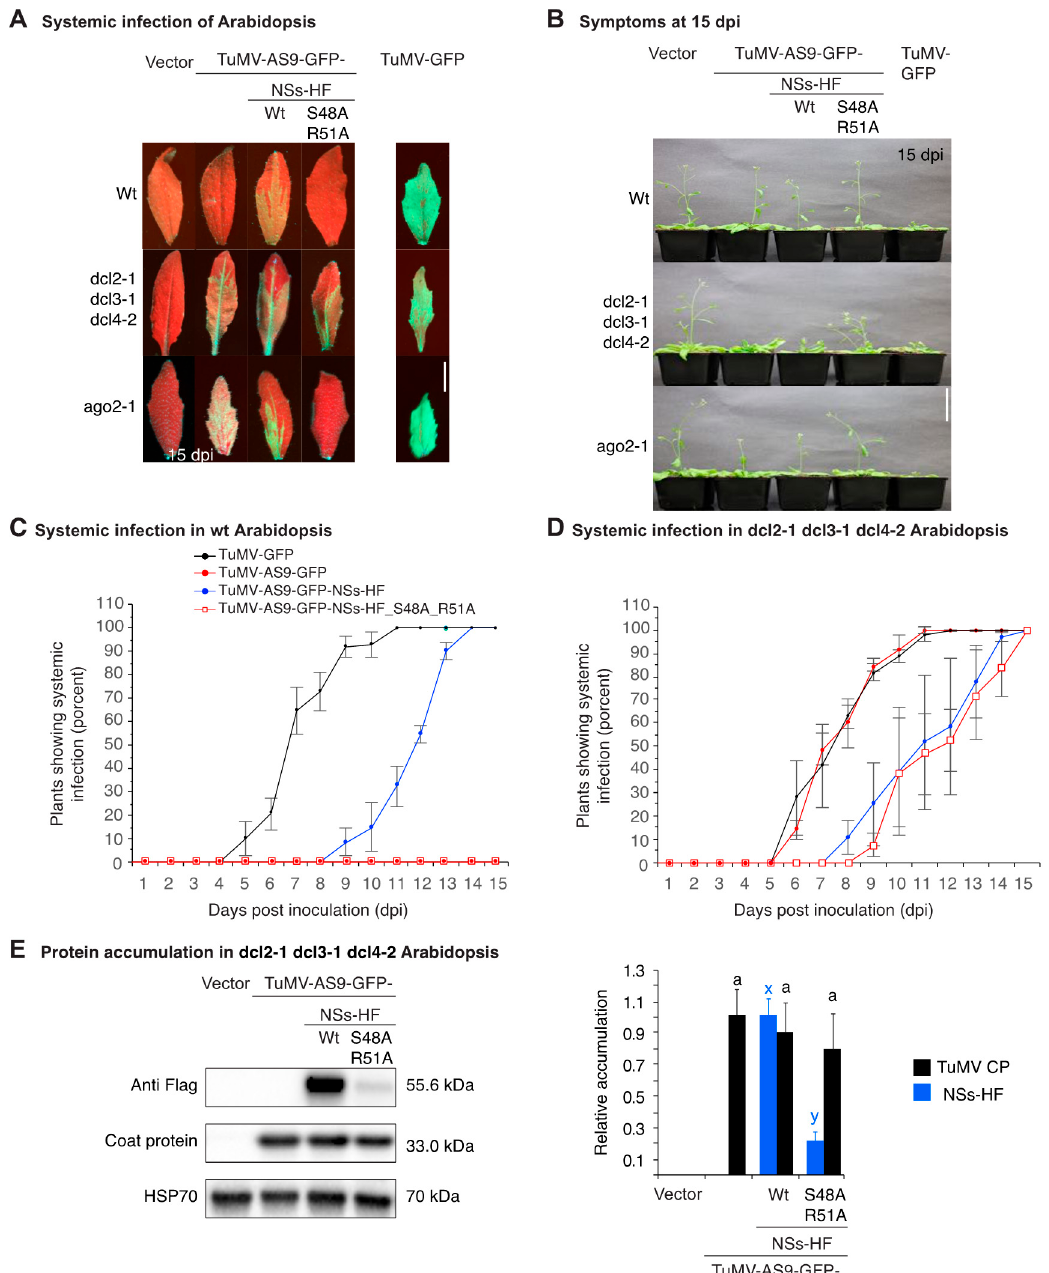
Figure 3. Pathogenicity and accumulation in A. thaliana (Arabidopsis). Wt, dcl2-1 dcl3-1 dcl4-2 triple, and dcl4-2 single mutant plants were inoculated by agroinfiltration with TuMV-AS9-GFP derivatives expressing NSs-HF, empty vector, TuMV-AS9-GFP or TuMV-GFP. ( A ) Visualization under UV light of systemic infection in cauline leaves at 15 dpi. Scale bar: 1 cm. ( B ) Representative plants showing symptoms at 15 dpi. Scale bar: 6 cm. ( C ) Proportion (%) of wt or ( D ) dcl2-1 dcl3-1 dcl4-2 triple mutant plants with systemic infection of inflorescence. Points represent average ( ± standard error) of three repetitions, each consisting of 12 plants per treatment. ( E ) Representative western blots showing NS-HF and coat protein accumulation at 10 dpi. HSP70 was used as a loading control. The histogram shows average ( ± standard error) coat protein or NSs-HF accumulation (four biological replicates) relative to TuMV-GFP or to wt NSs-HF, respectively. Bars with the same letter do not significantly differ (Tukey’s test with α =